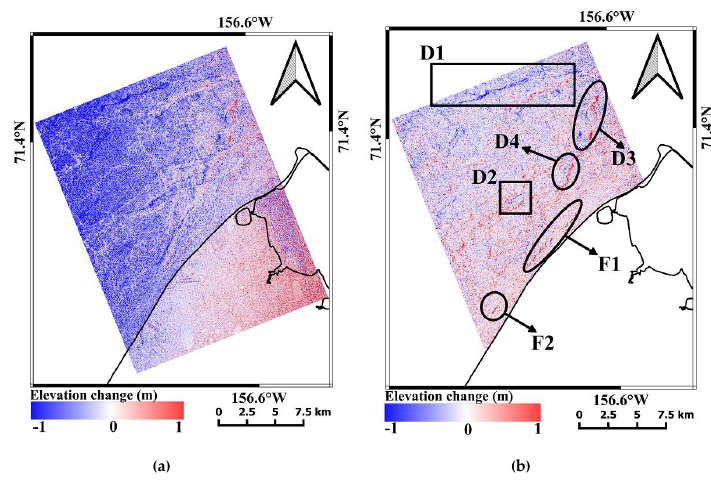
Figure 4. Height difference map (HDM) before ( a ) and after ( b ) removing the ramp in elevation change. Locations of ridge displacements are marked D1–4 and formation F1–2 in ( b ) and discussed further in the results section. The coastline is outlined in black and was used to mask out land and the ice in Elson Lagoon ( b ).